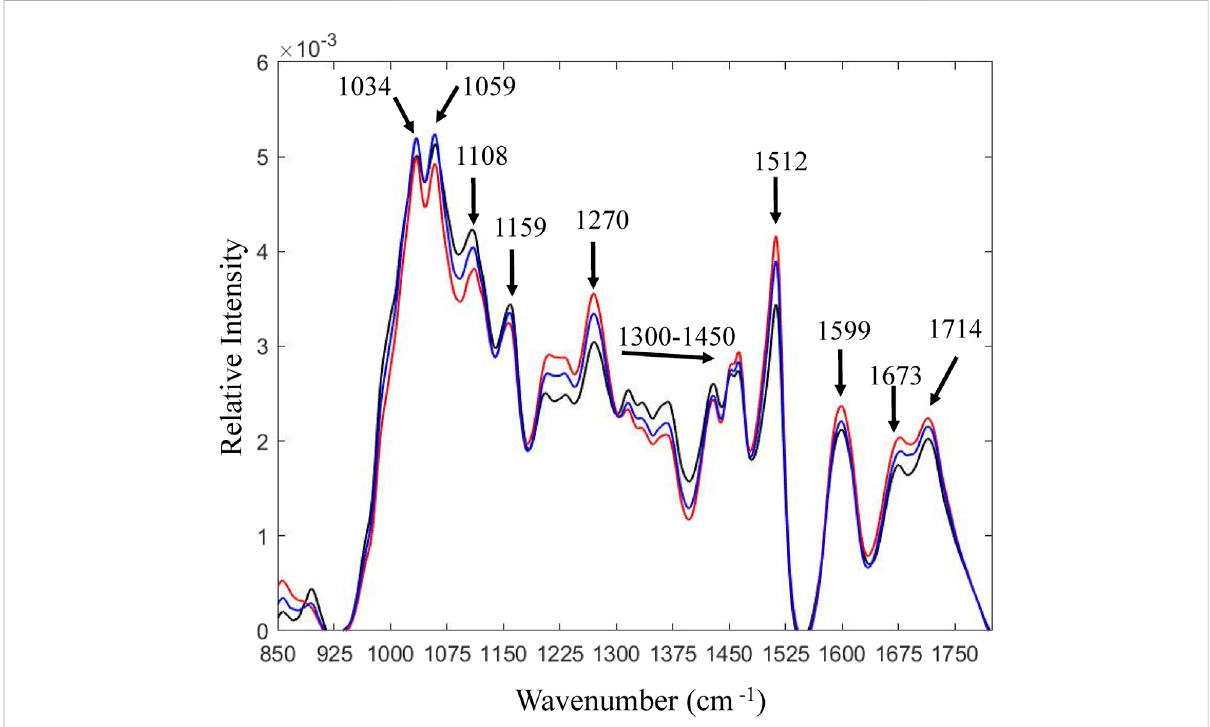
FIGURE 4 FTIRanalysisofpretreatedsolidsandsolidfractionsafter72 hofenzymaticsacchari fi cation.Blackline,pretreatedsolids;blueline,reactionwith N 2 ; red line, reaction with air. Observed differences re fl ect relative compositional changes [total area normalization was performed on the spectra using MATLAB software developed by ViSp (Vibrational Spectroscopy Core